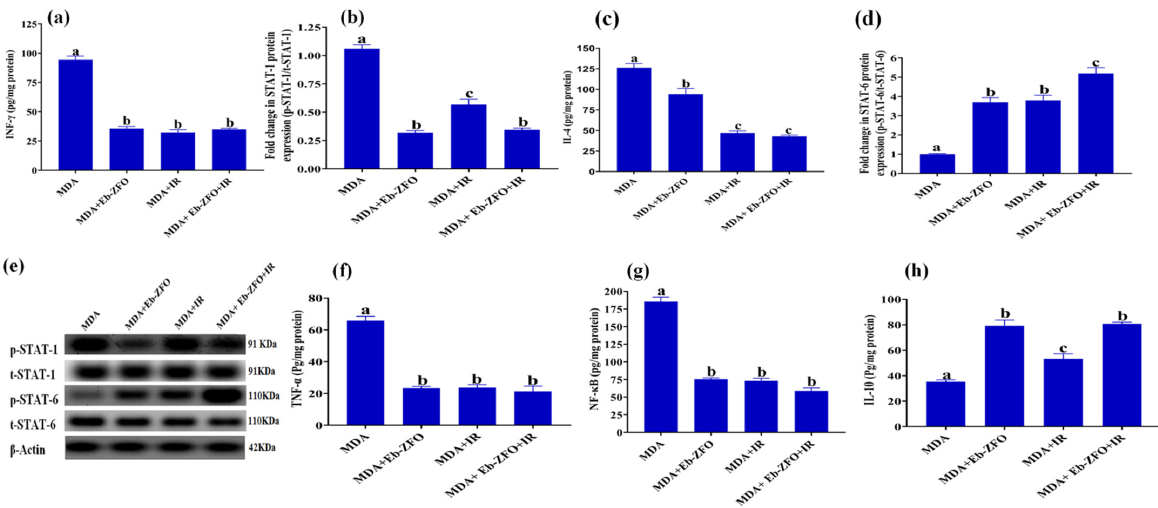
Figure 15. Inflammatory status and crosstalk of the signalling pathways TNF- α /NF- κ B, INF- γ /STAT-1, and IL-4/STAT-6 in MDA-MB-231 cells. Represented as follows; levels of ( a ) INF- γ , ( b ) protein expression of STAT-1, ( c ) IL-4, ( d ) protein expression of STAT-6, ( e ) representative western blot analysis, SDS-PAGE of STAT-1, STAT-6, and β - actin, ( f ) TNF- α , ( g ) NF- κ B and ( h ) IL-10. Results are expressed as the mean and standard error of the mean (SEM) (n = 3). Columns with dissimilar letters (a, b, c ... ) overhead within the same histogram are significantly different, and columns with the same let- ters are not significantly different at p < 0.05. MDA group: untreated MDA-MB-231 cells served as control, MDA + Eb-ZCFO group: MDA-MB-231 cells line treated with Ebselen (Eb) and ZnFe 2 O 4 nanoparticles (ZFO), MDA + IR group: MDA-MB-231 cells exposed to γ -radiation, and MDA + Eb-ZFO + IR group: MDA-MB-231 cells treated with Eb-ZFO and exposed to IR.